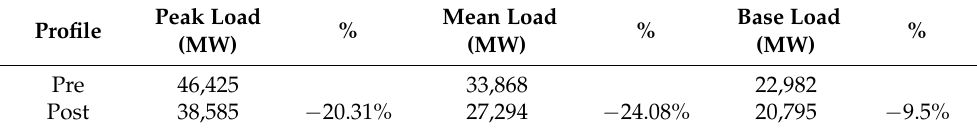
Table 1. Changes in demand profile using the data from the load duration curves.